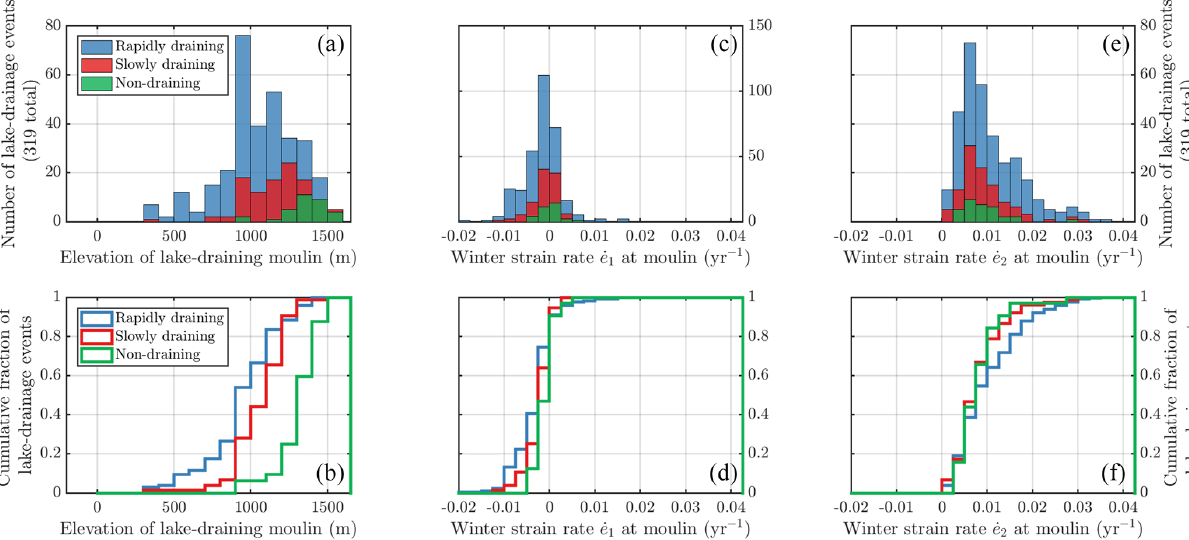
Figure 6. Distributions of elevation and strain rates at the locations of moulins associated with 78 supraglacial lakes, classified by drainage type of the lake (fast, slow, or non-draining). Moulins were located each year using WorldView imagery, when possible; when imagery was not available or when the lake did not drain, the moulin location was set to the center of the lake basin. (a) Histogram of elevations of the moulins at N = 319 lake drainage (or non-drainage) events over the 19 melt seasons from 2006–2010 and 2013–2018 whose type was ob- served with high confidence. (b) Cumulative distribution of the elevations of these moulins, separated by lake drainage type. (c) Background more compressional strain rate, ˙ (cid:15) 1 , observed the preceding winter for each lake-draining moulin. (d) Cumulative distribution of ˙ (cid:15) 1 , by lake drainage type. (e) Background more extensional strain rate, ˙ (cid:15) 2 , observed the preceding winter for each lake-draining moulin. (f) Cumulative distribution of ˙ (cid:15) 2 , by lake drainage type. Strain rates are calculated with the near-yearly wintertime mosaics, MEaSUREs Greenland Ice Sheet Velocity Map from InSAR Data, Version 2 (Joughin et al., 2018b, 2010), supplemented with ESA Climate Change Initiative in winters 2013 and 2017 (Boncori et al., 2018) when MEaSUREs data are not available, as shown in Fig.